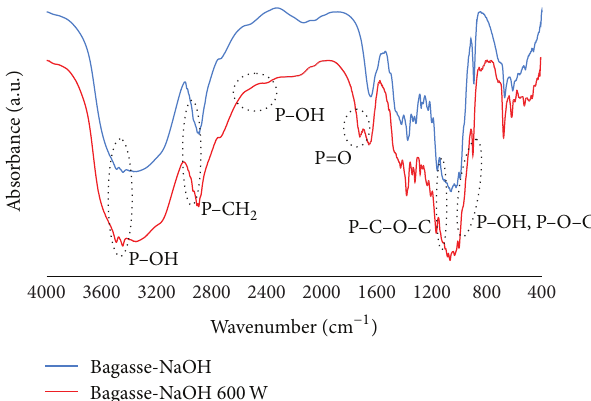
Figure 6: IR spectra of unmodified bagasse after treatment by NaOH solution (Bagasse-NaOH) and modified bagasse (Bagasse- NaOH 600 W).